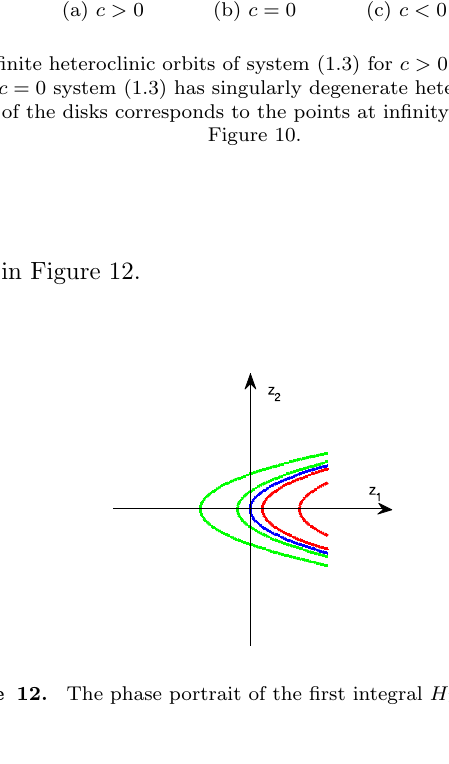
The flow in the local chart V 1 is the same as the flow in the local chart U 1 reversing the time, because the compactified vector field p ( X ) in V 1 coincides with the vector field p ( X ) in U 1 multiplied by −